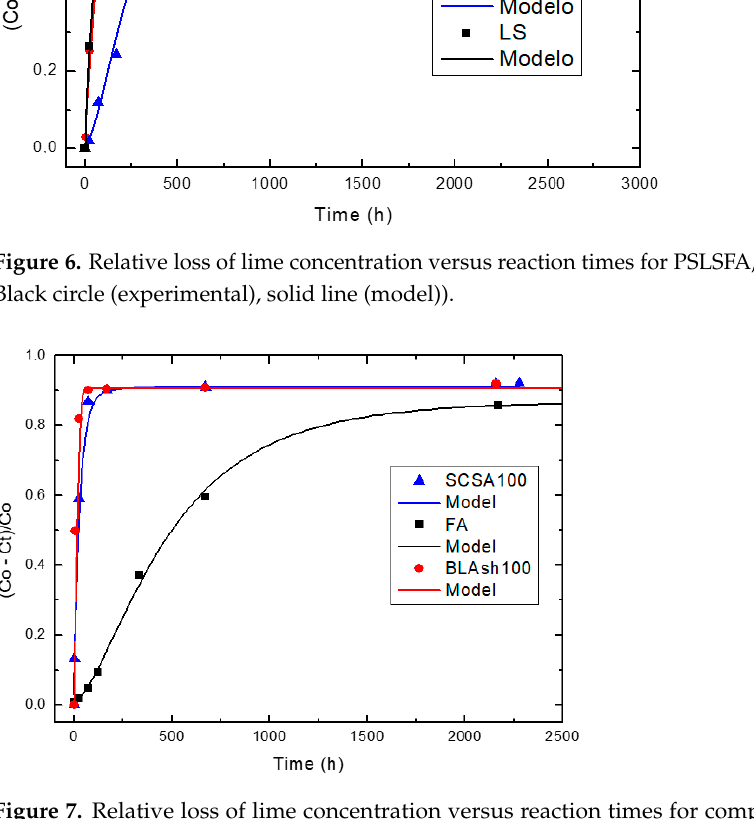
Figure 7. Relative loss of lime concentration versus reaction times for complementary pozzolans SCSA100, FA and BLAsh100 ( Note : Black circle (experimental), solid line (model)). The values of the parameters ( τ , K and C corr ) are given in Table